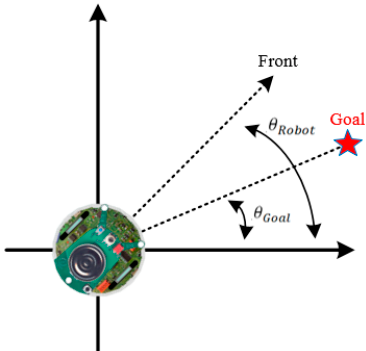
Figure 22. Angle between the robot and the target location.